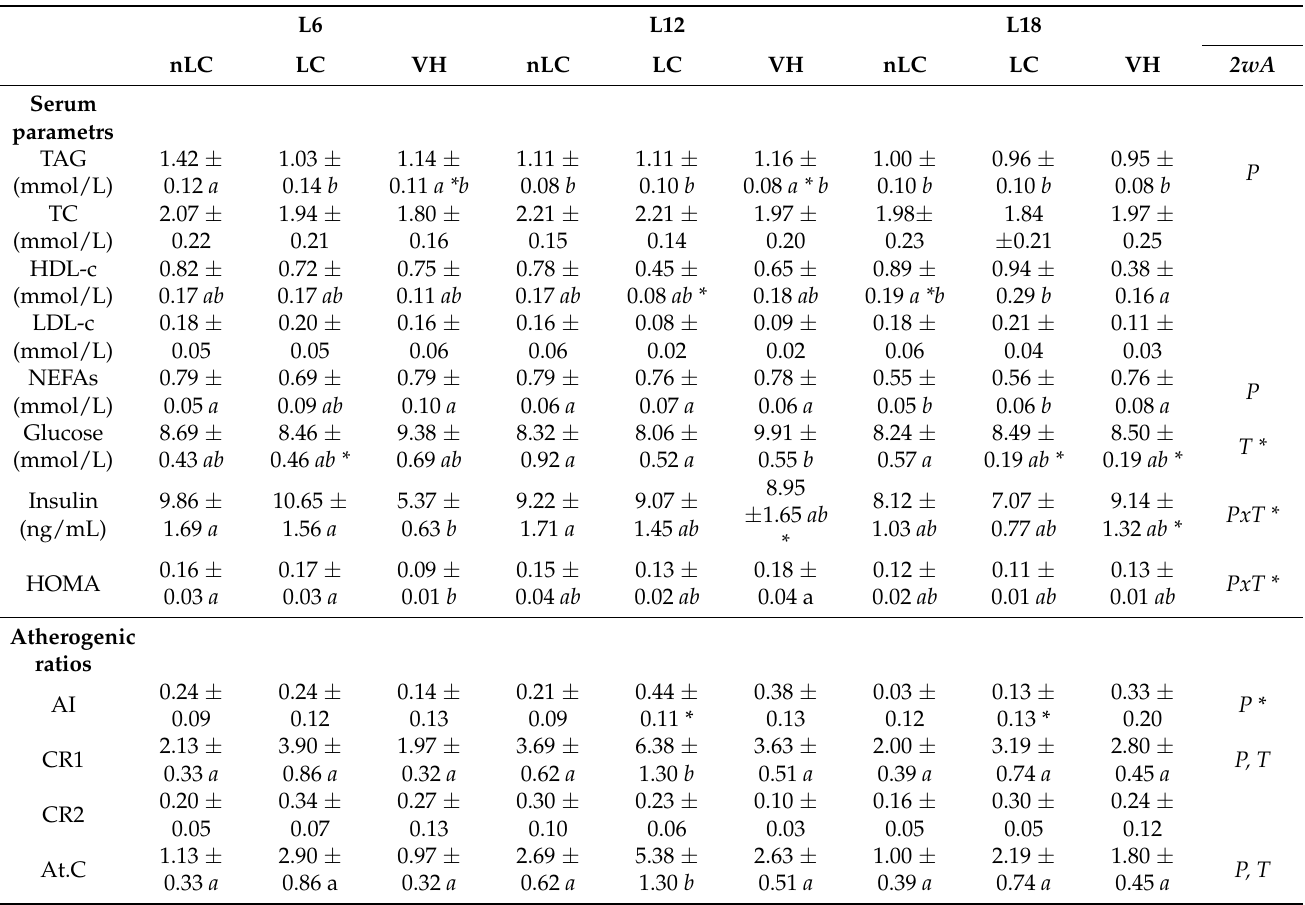
Table 1. Plasma parameters and atherogenic indices in Fischer 344 rats exposed to different photoperiods and supplemented with local or non-local cherry or vehicle for 7